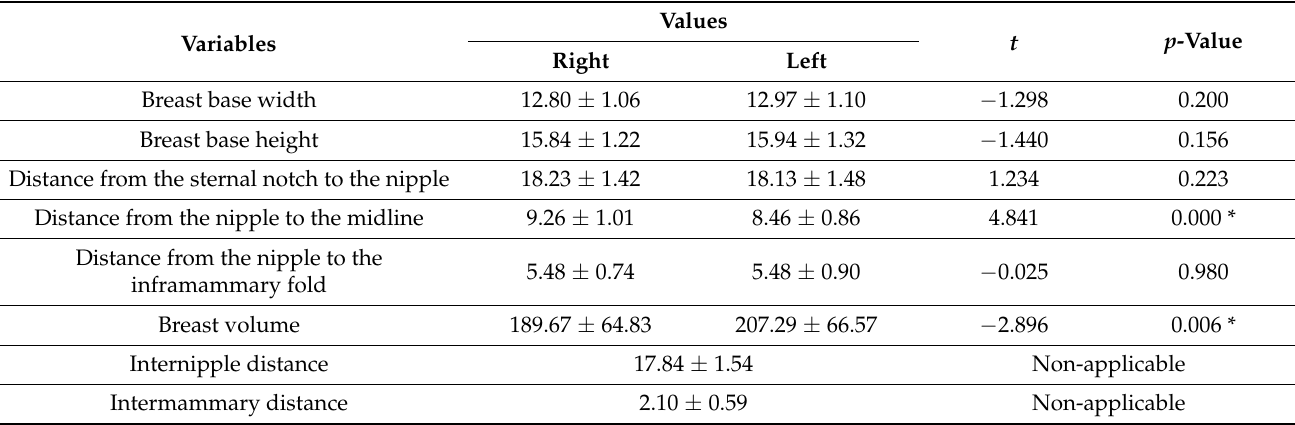
Table 2. Preoperative anthropometric measurements obtained on the Divina TM 3-dimensional